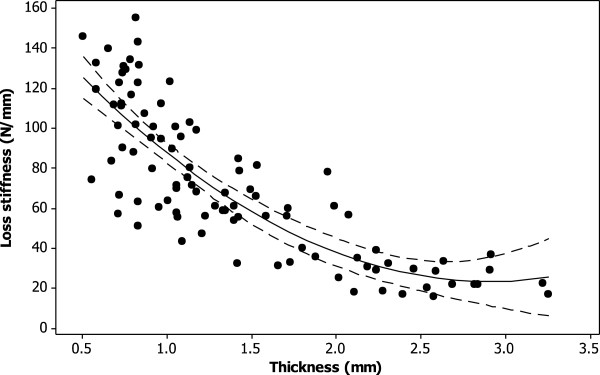
Thickness dependent loss stiffness of knee joint cartilage at 1 Hz. A second order polynomial curve (see equation 2) was fitted to the experimental data (R2 = 69%; p < 0.05) as shown (solid line). The 95% confidence intervals are also included (dashed line).